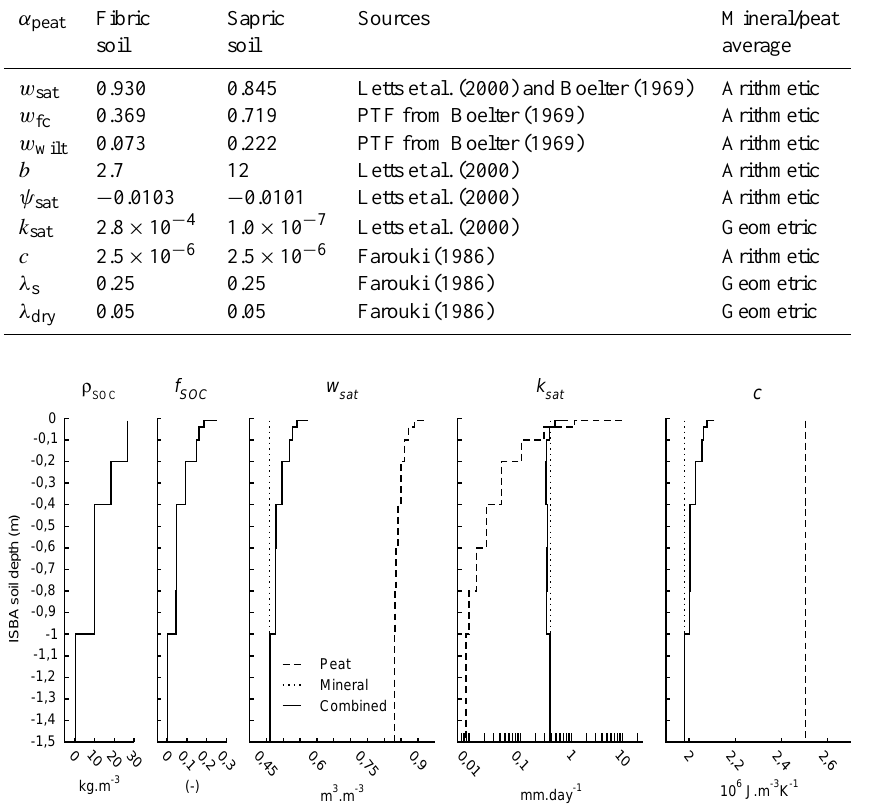
Figure 2. Parameterization of the effect of soil organic carbon (SOC) on soil hydraulic and thermal properties. The soil organic carbon density profile, ρ soc , is given by Eq. (21) using a top soil organic carbon content of 10kgm − 2 , a subsoil content of 15kgm − 2 , and via a simple linear interpolation at each soil grid nodes that conserves the total soil carbon mass. The fraction of the soil that is organic, f soc , in each layer is determined assuming a simple relationship between this last soil organic carbon density profile and an idealized peat soil density profile (Eq. 22). Examples for the soil porosity, w sat , the soil saturated hydraulic conductivity, k sat , and the soil heat capacity, c , are given. Dotted lines represent vertical homogeneous mineral soil properties, dashed lines the idealized peat soil properties, and plain lines the resulting combined soil properties using the averaging method summed up in Table